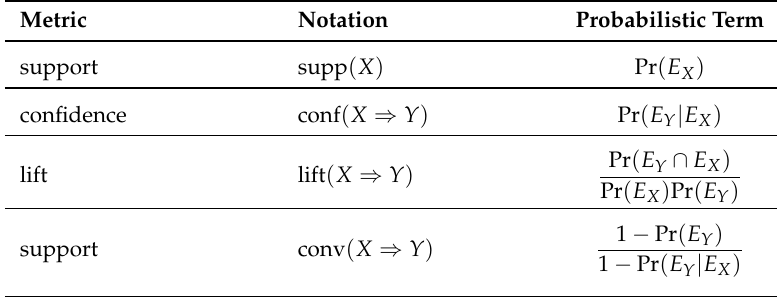
Table 2. The various metrics in probabilistic